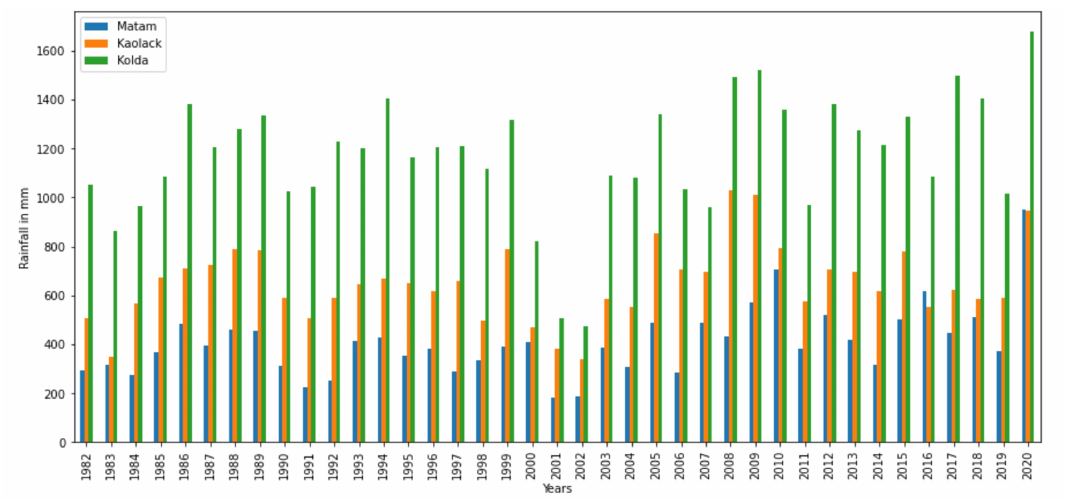
Figure 3. Annual cumulative rainfall variation for Matam, Kaolack and Kolda